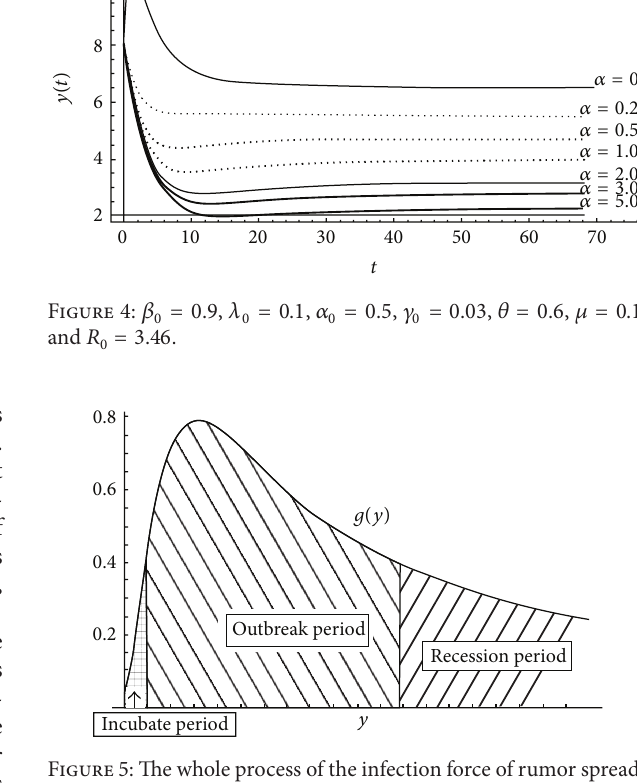
Figure 5: The whole process of the infection force of rumor spread- ing with psychological